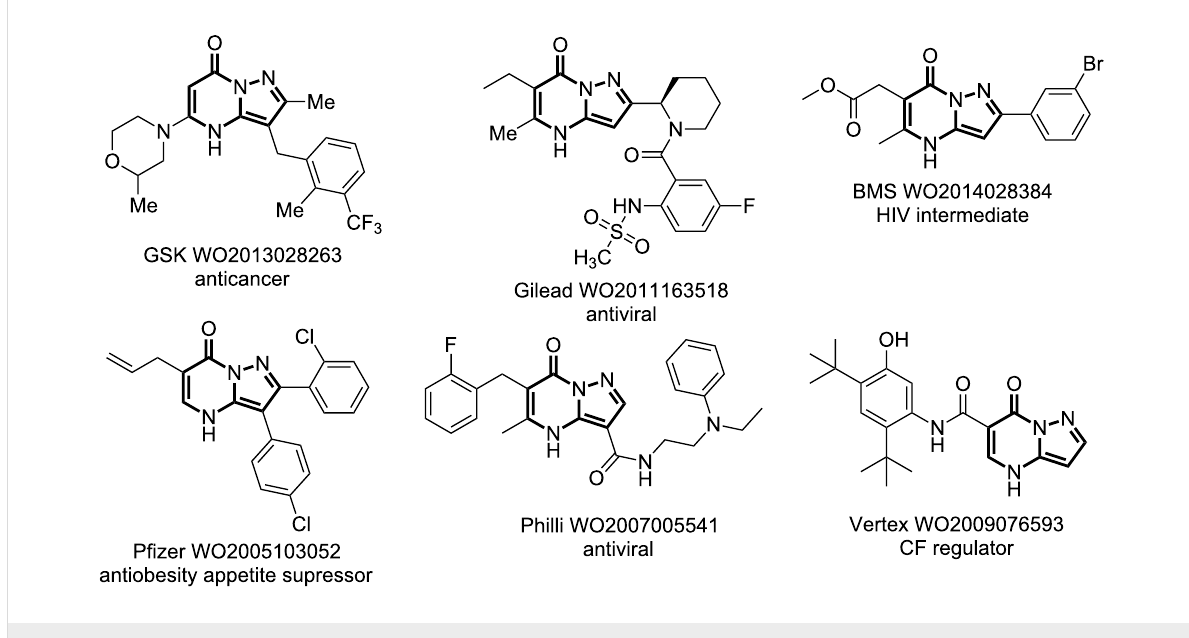
Figure 1: Bioactive pyrazolo[1,5- a ]pyrimidinones.